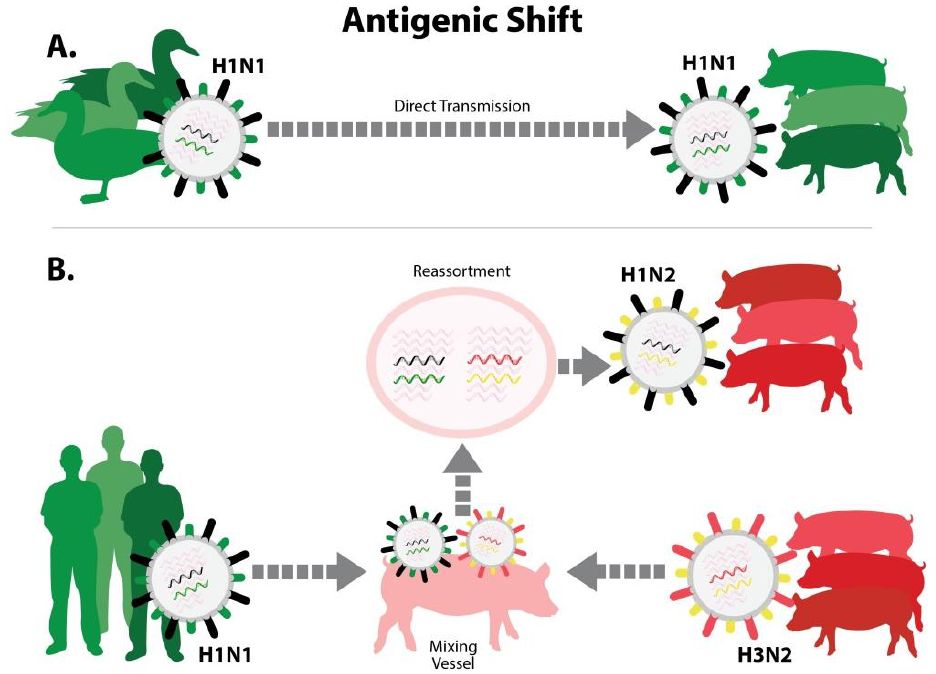
Figure 2. Antigenic shift. There are two ways that an influenza virus with new antigenic properties may enter the pig population. ( A ) Virus that was previously adapted to another animal host, such as avian species, enters pigs and adapts to circulate efficiently in swine. The diagram portrays the inter-species transmission of an avian H1N1 virus, which became established in European swine populations; ( B ) Virus previously adapted to another host, such as birds or humans, co-infects a pig along with a common swine-adapted strain. This can lead to gene reassortment, producing a new “reassortant” virus that contains an HA and/or NA antigenically different from those that previously circulated in swine. The diagram portrays reassortment between human seasonal H1N1 and swine H3N2 viruses. In both ( A ) and ( B ), the swine population lacks antibodies to important surface proteins of the new